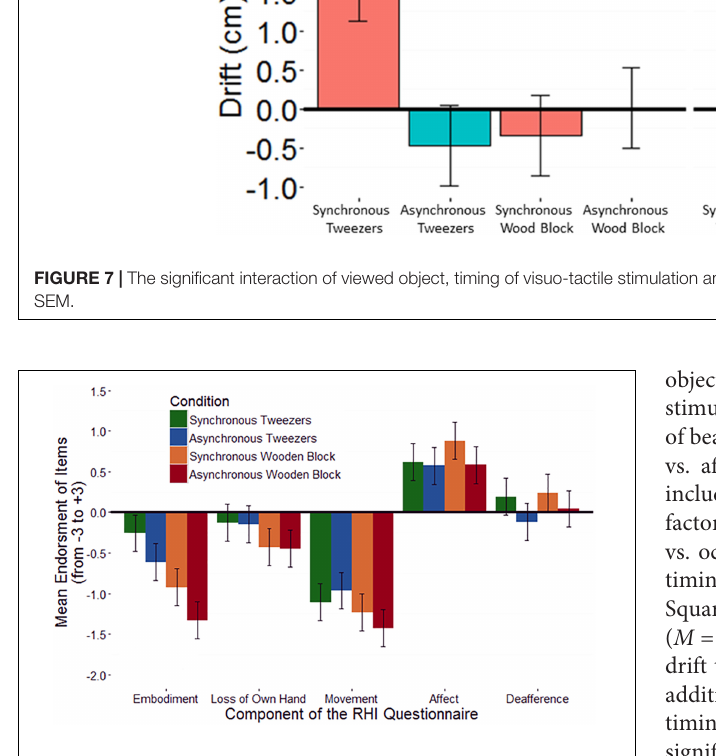
FIGURE 8 | The non-significant interaction between RHI condition and questionnaire component for the tweezers-version of the RHI. Error bars represent ± 1